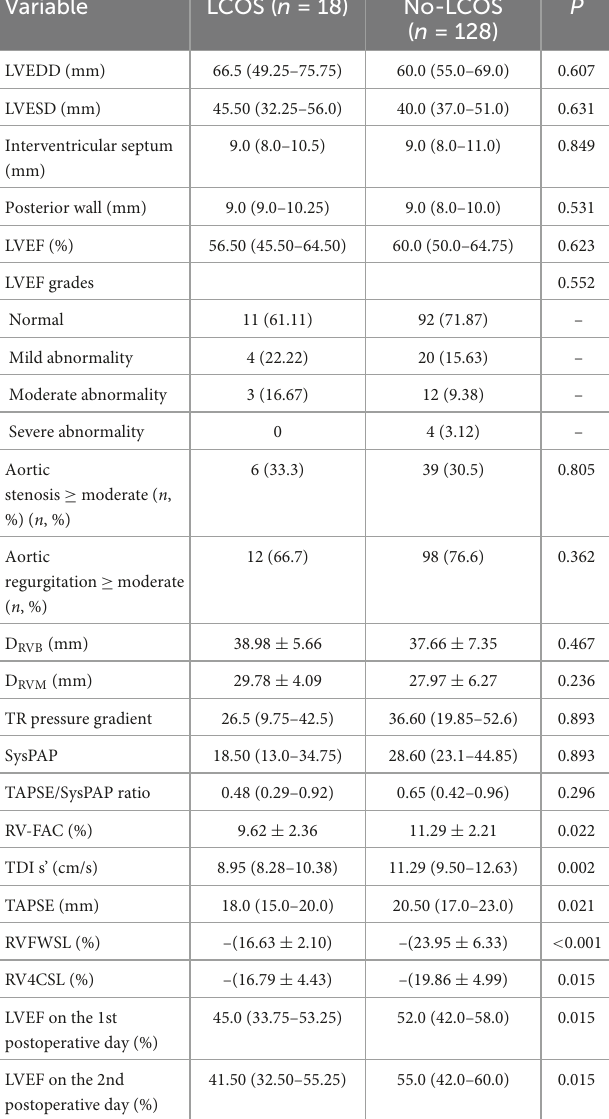
TABLE 2 Echocardiographic parameters in patients with